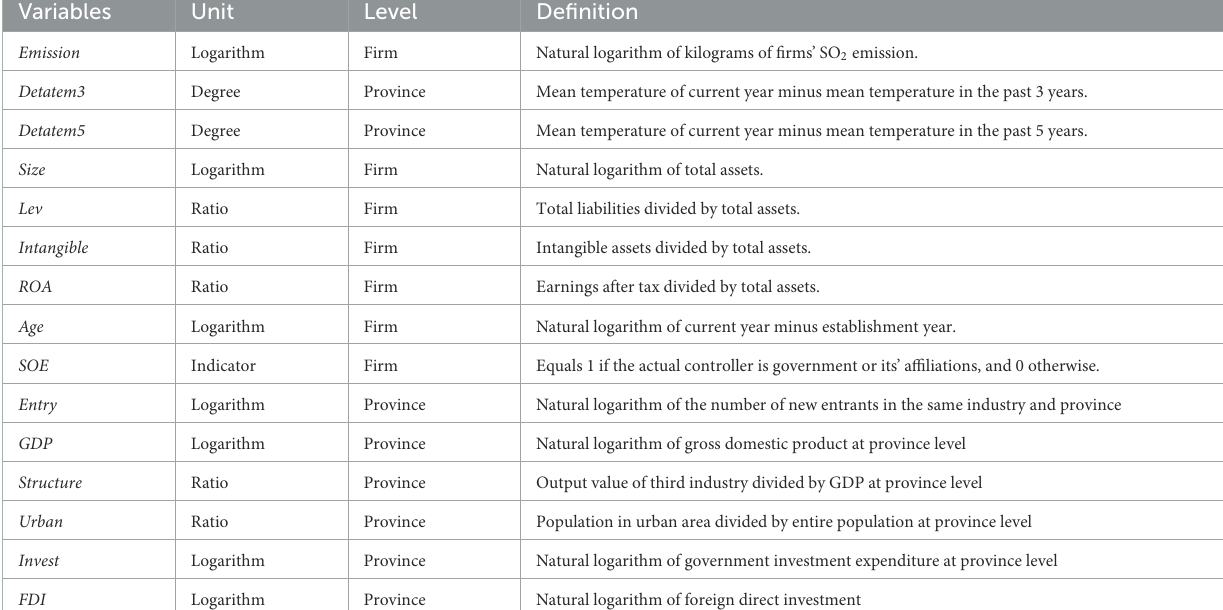
TABLE 1 Variable definitions.